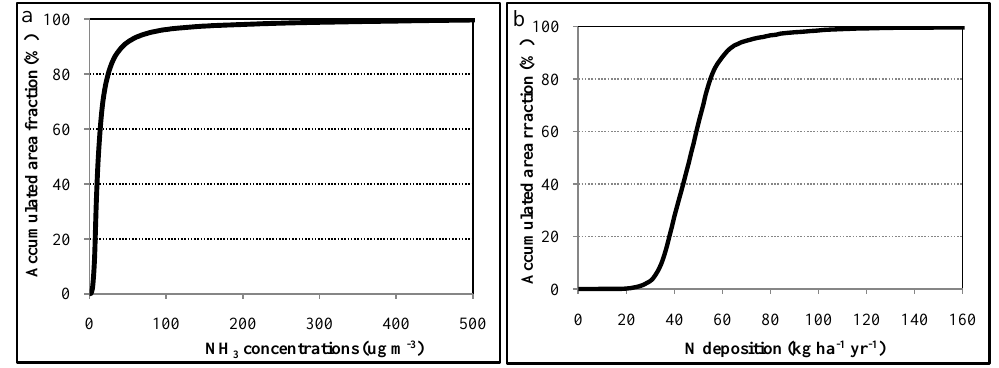
Fig. 8. Accumulated area fraction of grid cell NH 3 concentration (a) and N deposition (b) in the NCP in 2008.